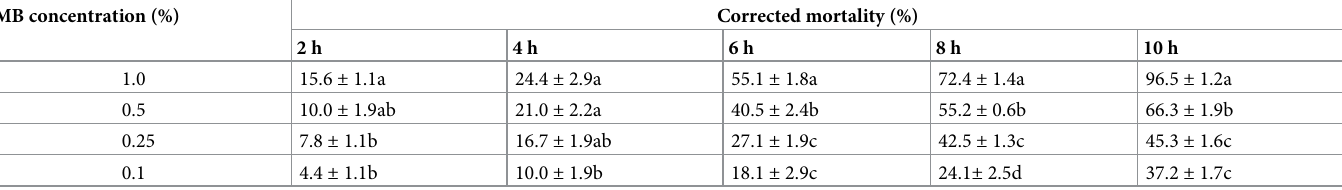
Table 5. Fumigant toxicity of methyl benzoate determined as a percentage of Bemisia tabaci corrected mortality after 2 h, 4 h, 6 h, 8 h, and 10 h exposure in the laboratory. MB concentration (%)